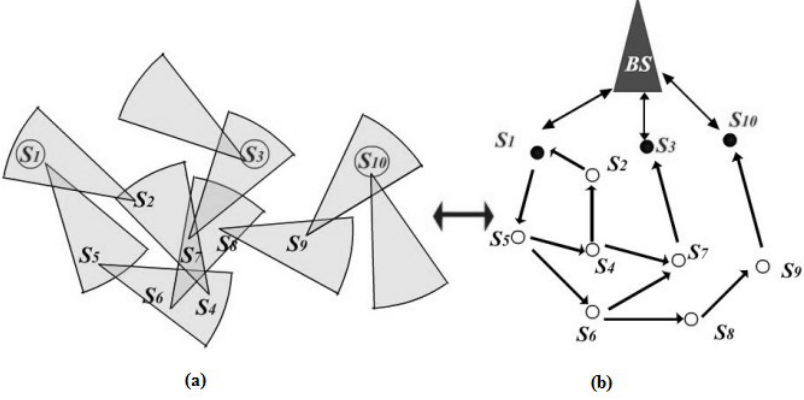
Figure 2. ( a ) An example of FSOSN; ( b ) Hierarchical network structure.